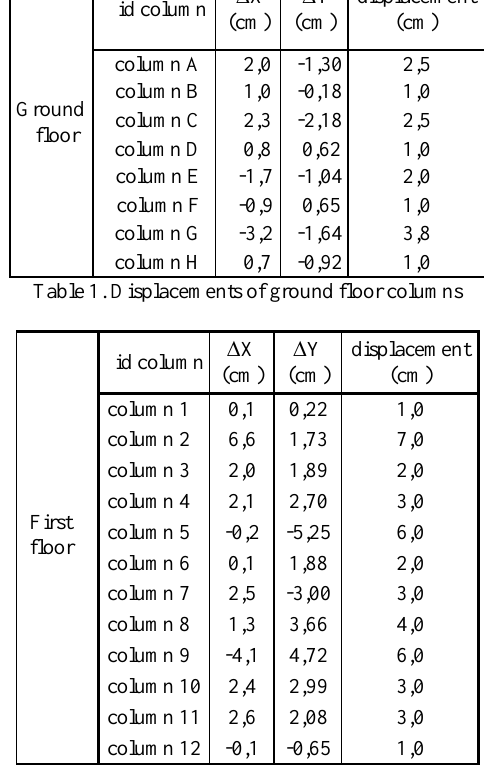
Table 2. Displacements of ground floor columns